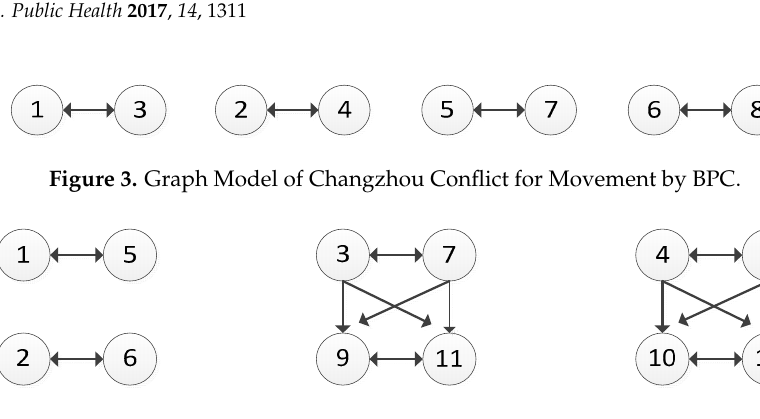
Figure 4. Graph Model of Changzhou Conflict for Movement by GC.